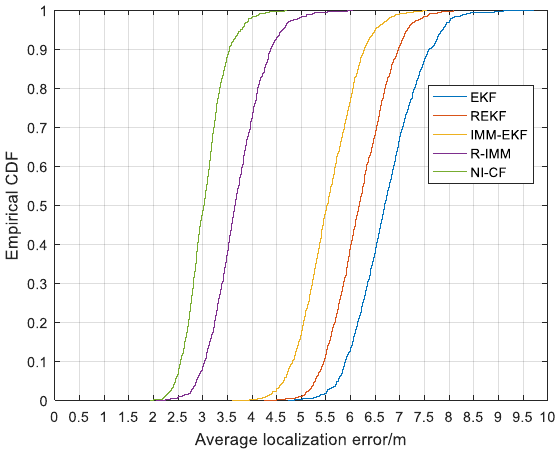
Figure 12. The CDF versus the ALE.